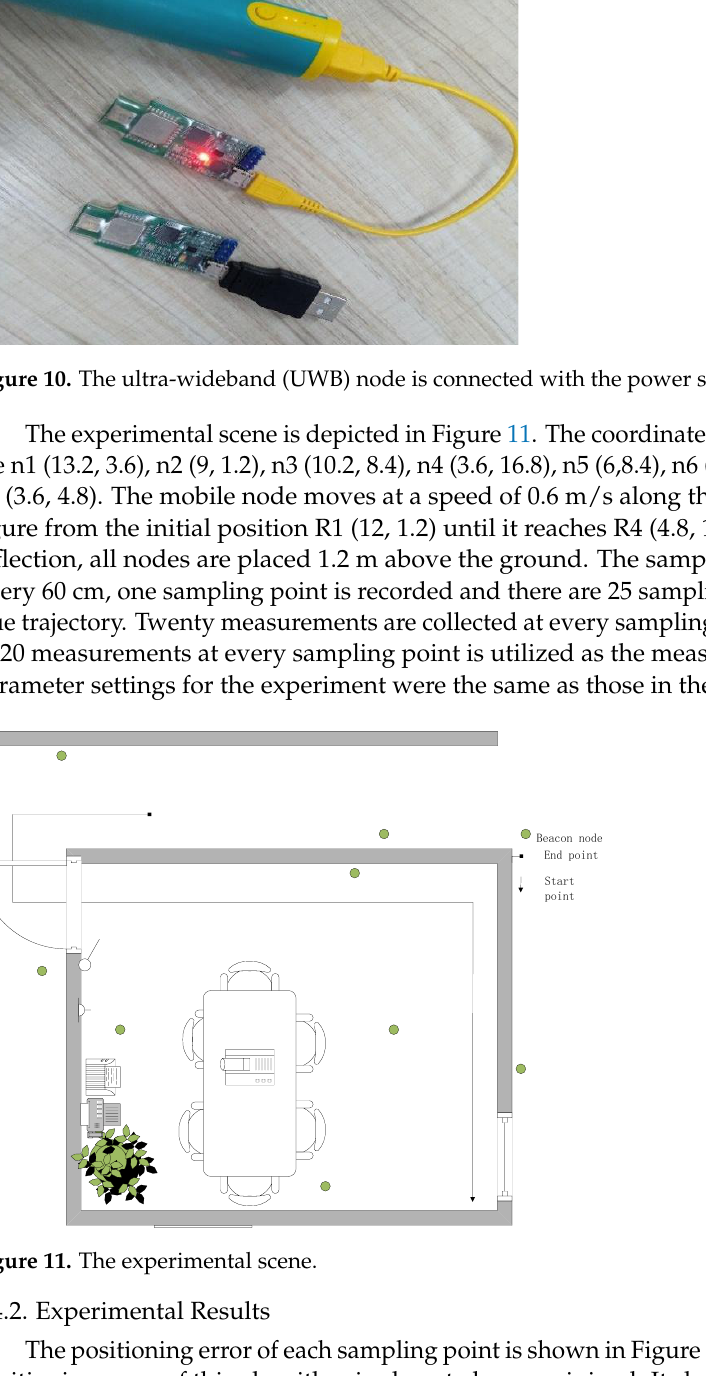
16 of 19 Figure 9. NLOS uniform distribution parameters . 5.4. Experiment 5.4.1. Experimental Environment In order to test the performance of the proposed algorithm, we conducted a localiza- tion experiment in an indoor environment. The signal transmission between the mobile node and beacon nodes was based on ultra-wideband (UWB) technology. UWB technol- ogy has been widely used in indoor positioning in recent years because of its low com-